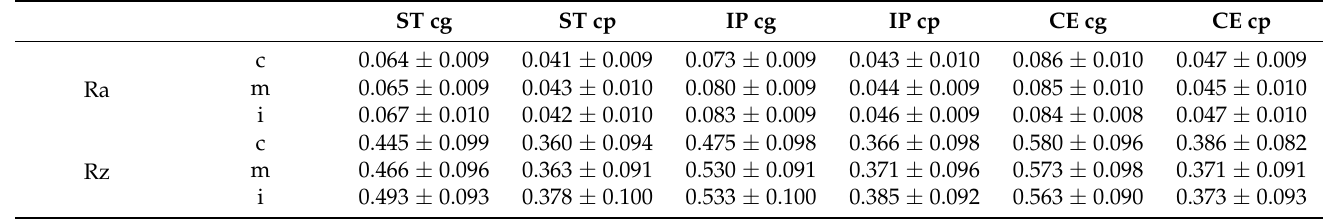
Table 2. Mean values with SD for Ra, Rz parameters of the samples, before aging (n = 8). ST cg ST cp IP cg